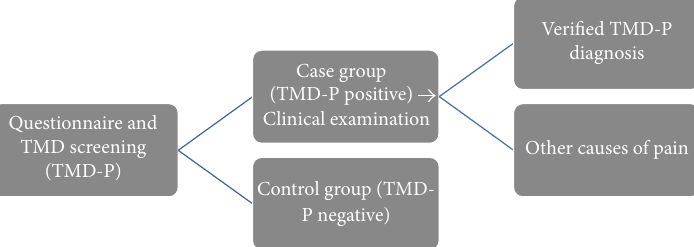
Figure 1: Flowchart showing the design of the study. Screening consisted of a questionnaire and two TMD-P screening questions. Patients with a positive TMD-P response underwent a clinical examination. Patients with a negative TMD-P response served as controls. The clinical examination revealed either actual TMD-P or other